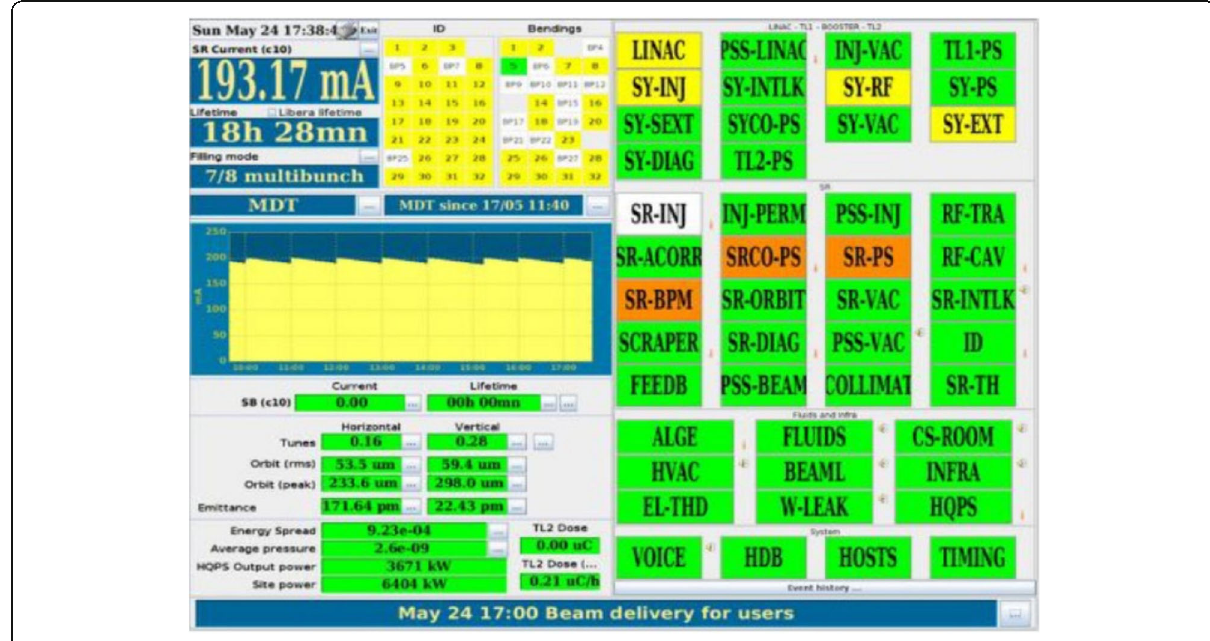
Fig. 15 Commissioning status of ESRF-EBS in